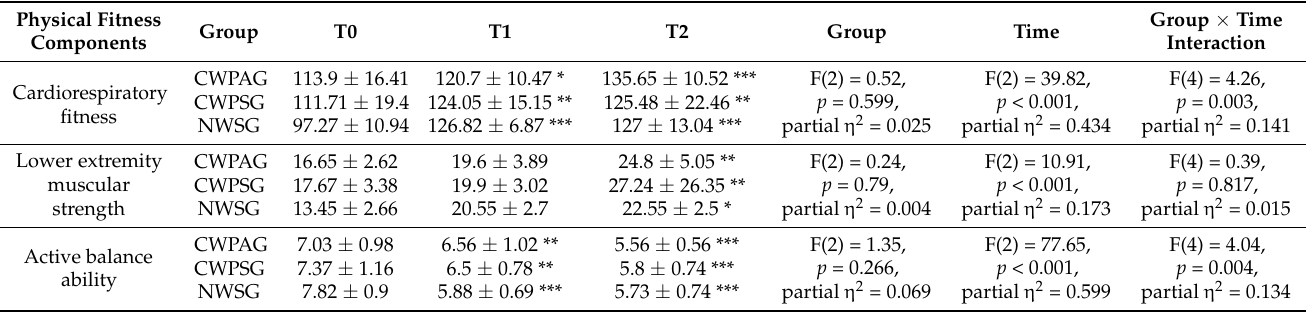
Table 3. Comparison of physical